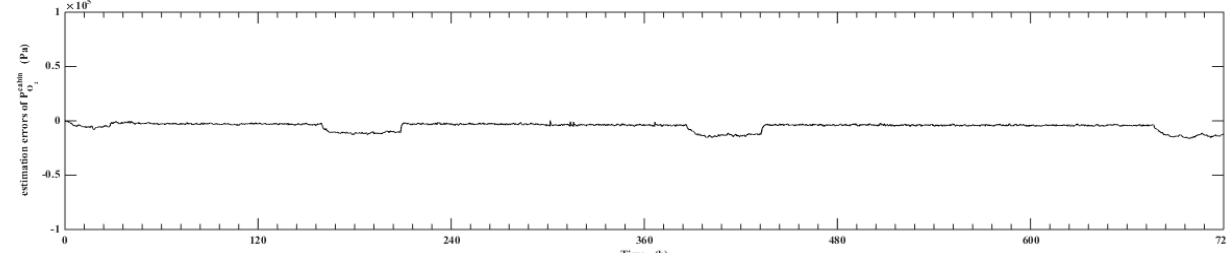
Figure 9. Estimation error of the partial pressure of oxygen in cabin.